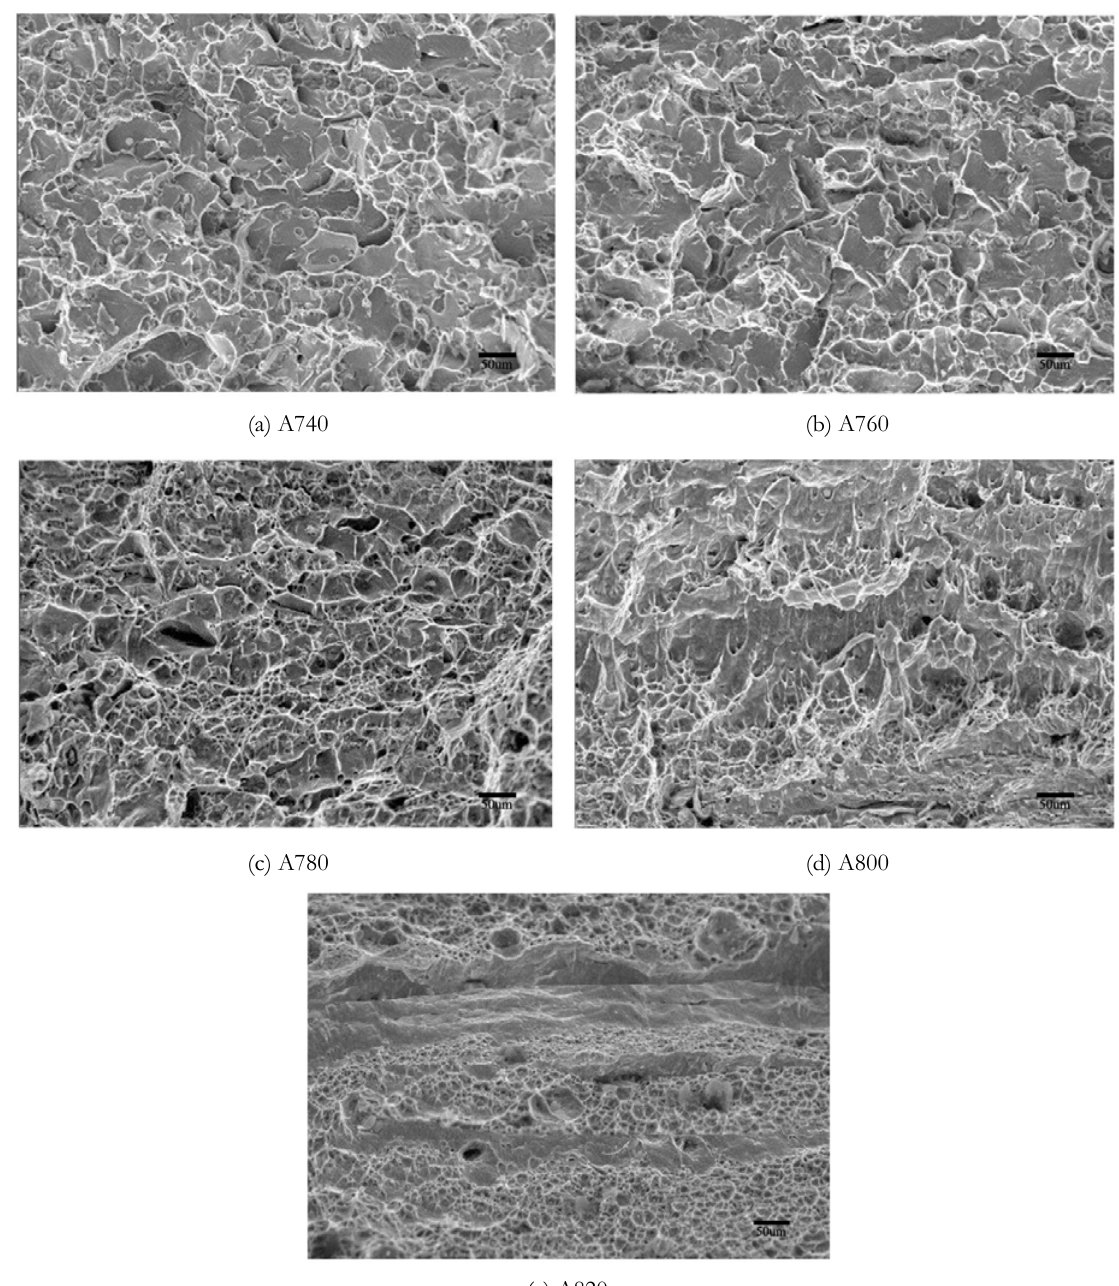
Figure 3: Microstructure of fractured surfaces for DP